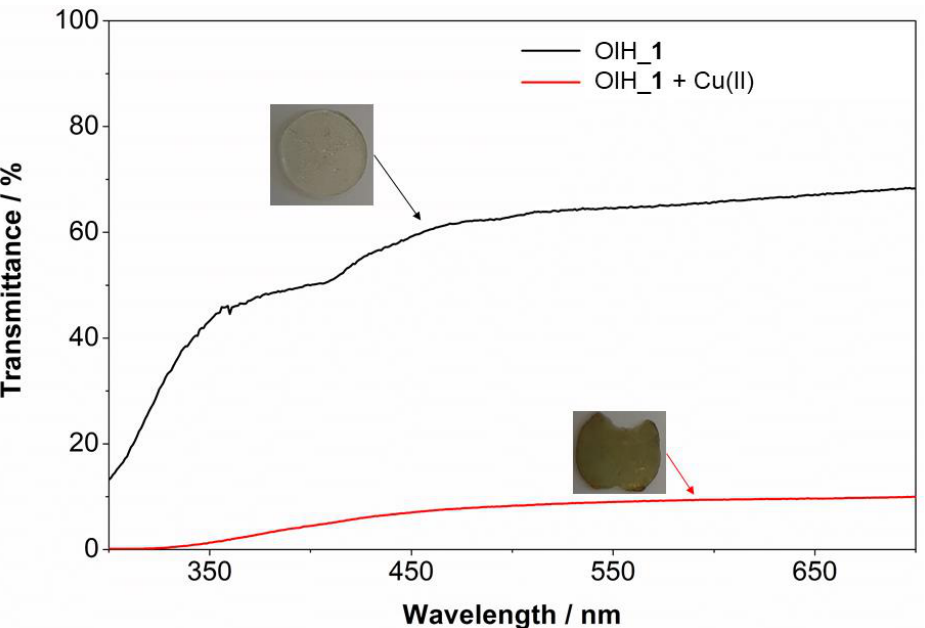
Figure 4. Transmittance spectra for OIH doped with compound 1 (OIH_ 1 ) and the same material after being immersed on a Cu(II) (10 −3 M) ACN solution (OIH_ 1 + Cu(II)).